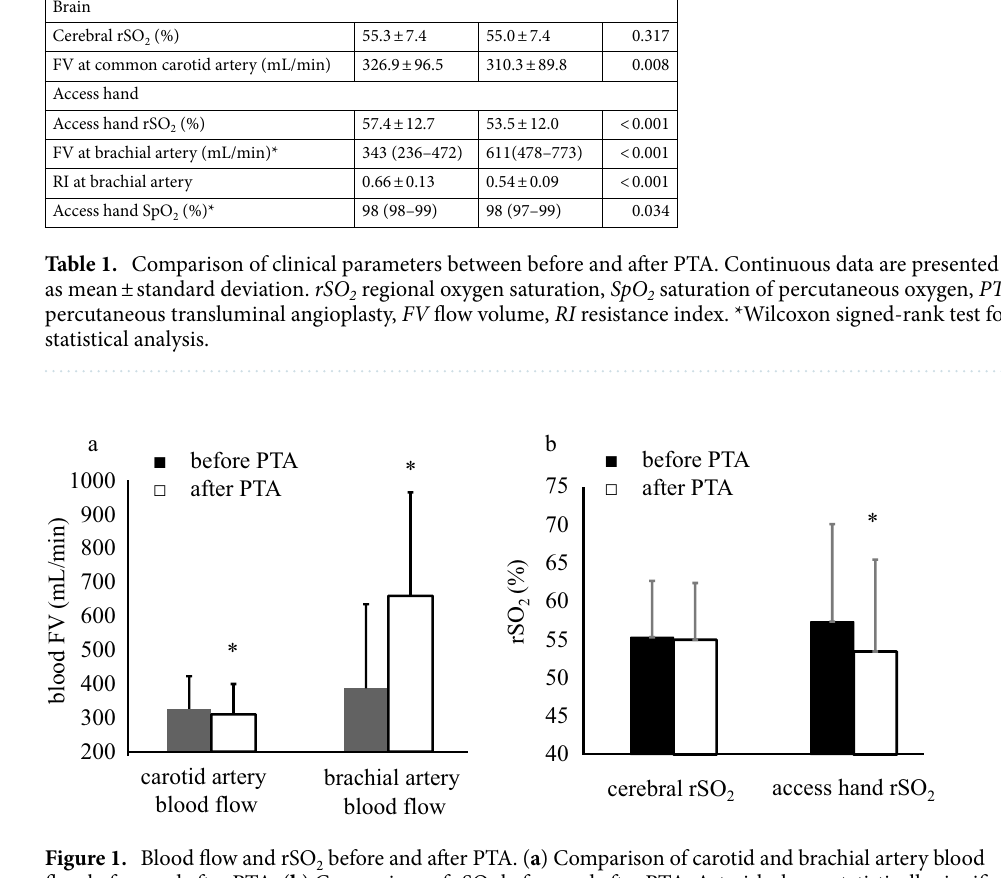
Figure 1. Blood flow and rSO 2 before and after PTA. ( a ) Comparison of carotid and brachial artery blood flow before and after PTA. ( b ) Comparison of rSO 2 before and after PTA. Asterisk shows statistically significant compared with before PTA. PTA percutaneous transluminal angioplasty, FV flow volume, rSO 2 regional oxygen